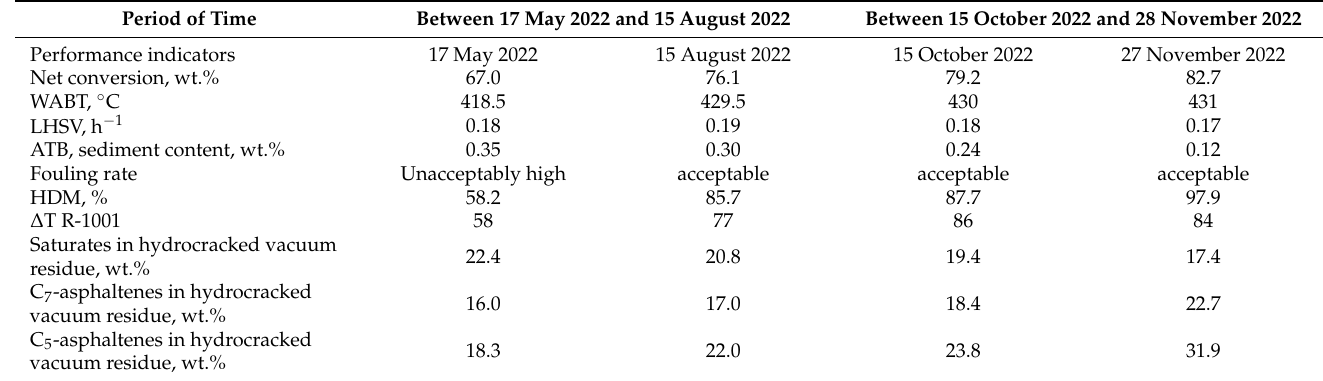
Table 2. Main performance indicators of the commercial ebullated bed vacuum residue hydrocracker during the periods when 100% Urals and Siberian Light vacuum residues were